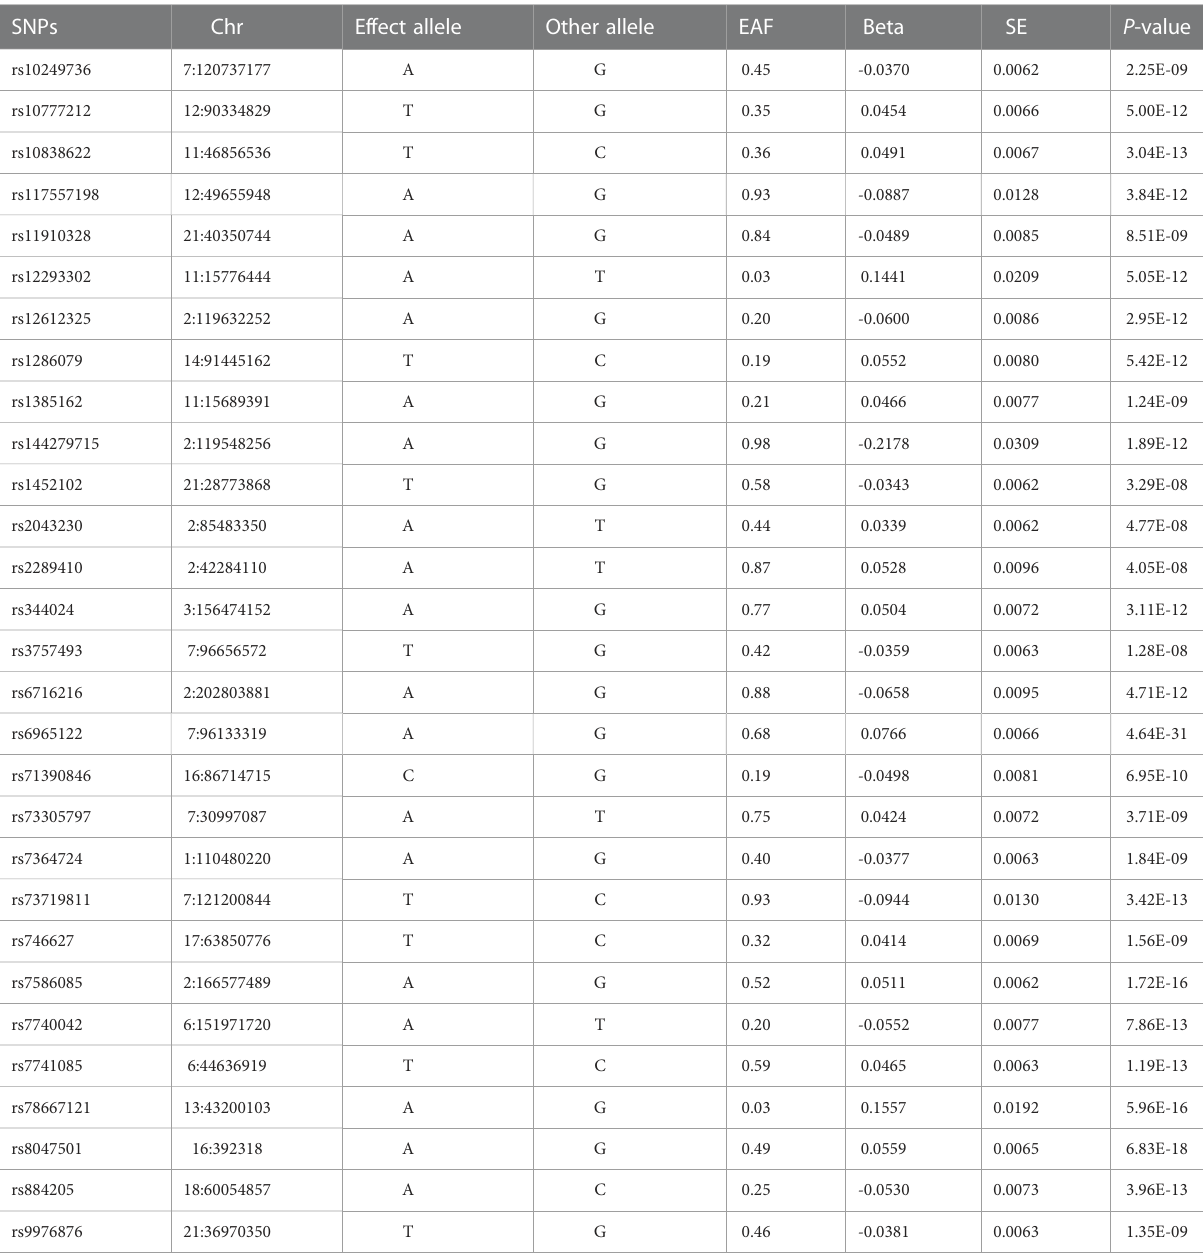
TABLE 2 Characteristics of SNPs for